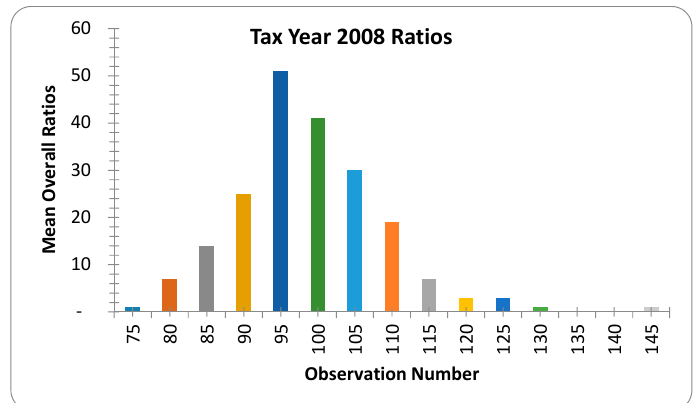
Figure 2. Overall ratios for New London in the tax year 2008. The observation number (horizontal axis) is a range, and the Mean Overall Ratio (vertical axis) is the mean overall ratio in the corresponding range. For instance, 75 indicates observations 0 to 75; 80 indicates observations 76 to 80; . . . ; 145 indicates observations 140 to 145.